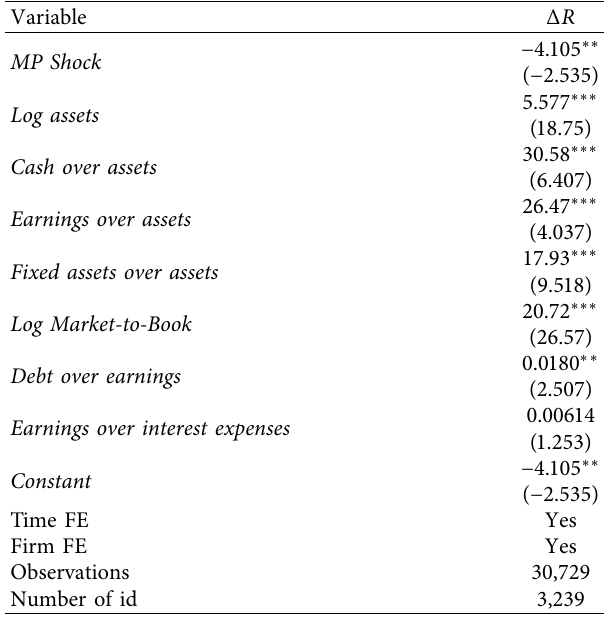
Table 3: Stock price effect of unexpected